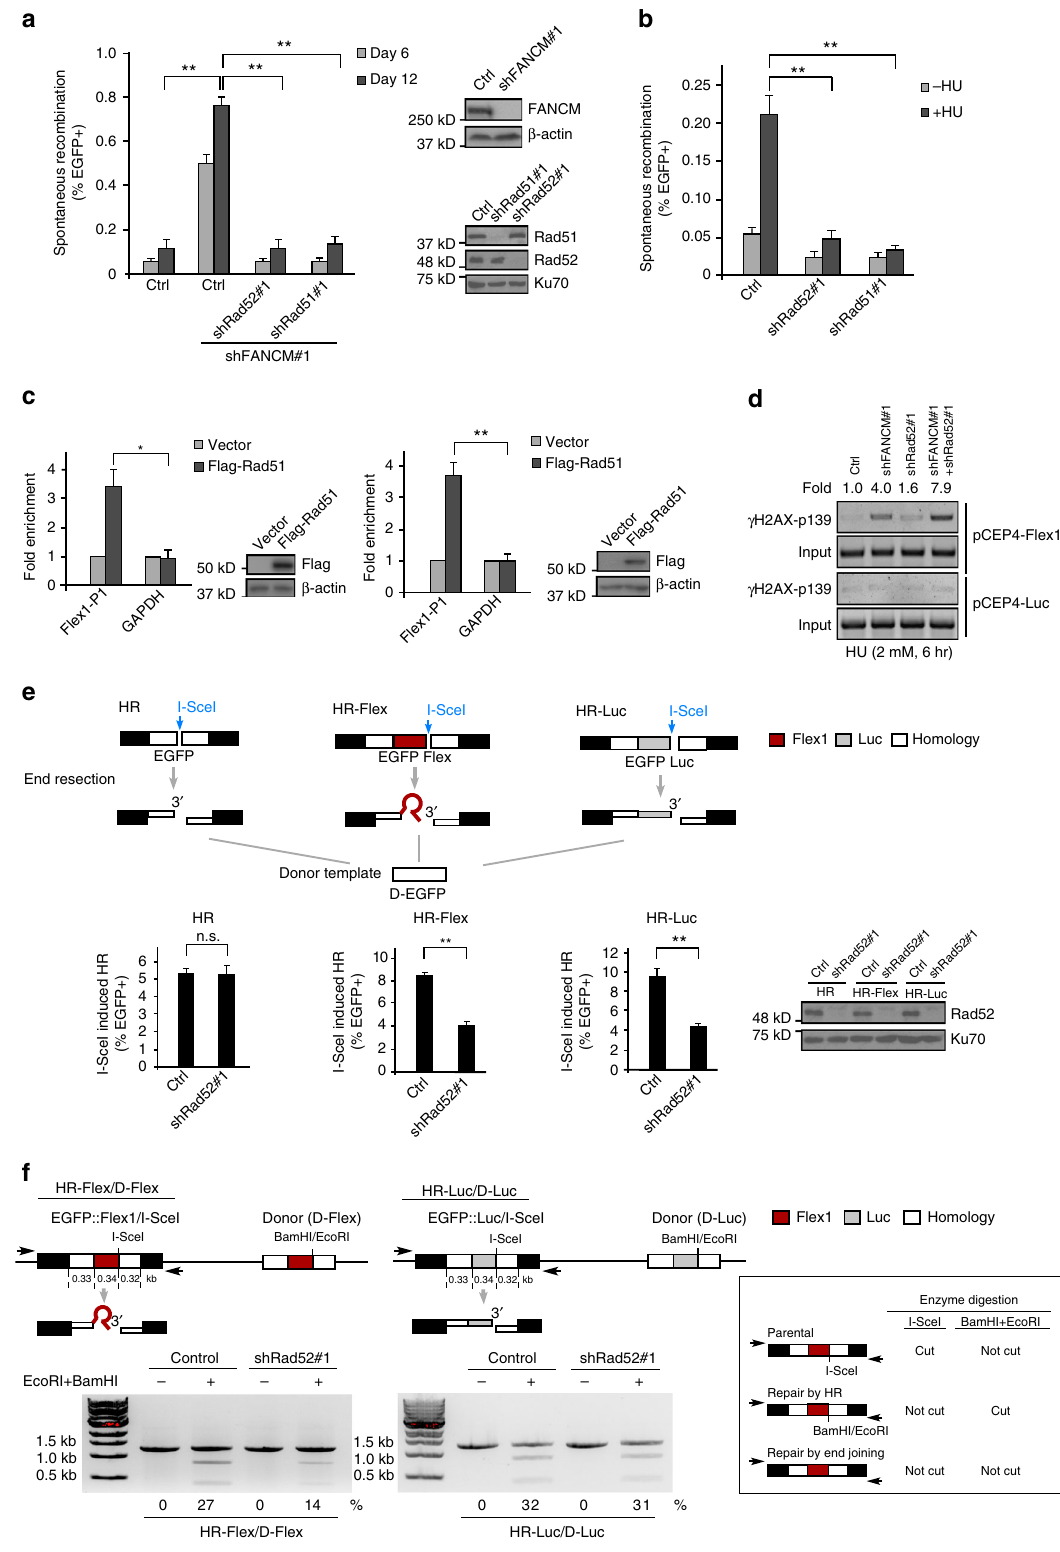
Parental I-SceI Repair by HR BamHI/EcoRI Repair by end